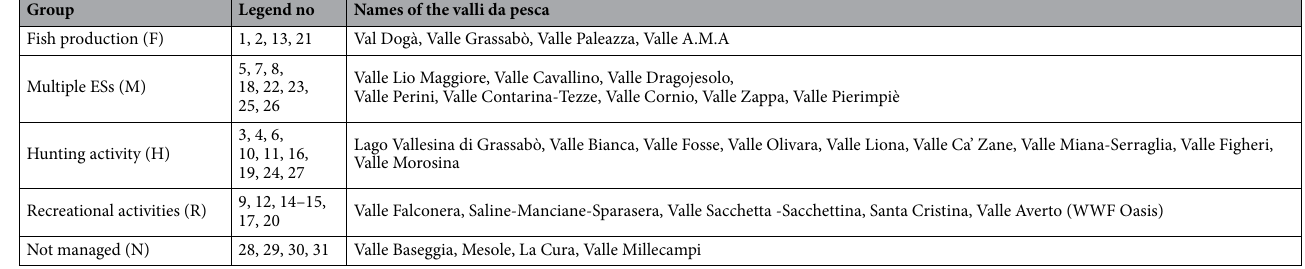
Table 1. The five groups of valli da pesca, according to the adopted management